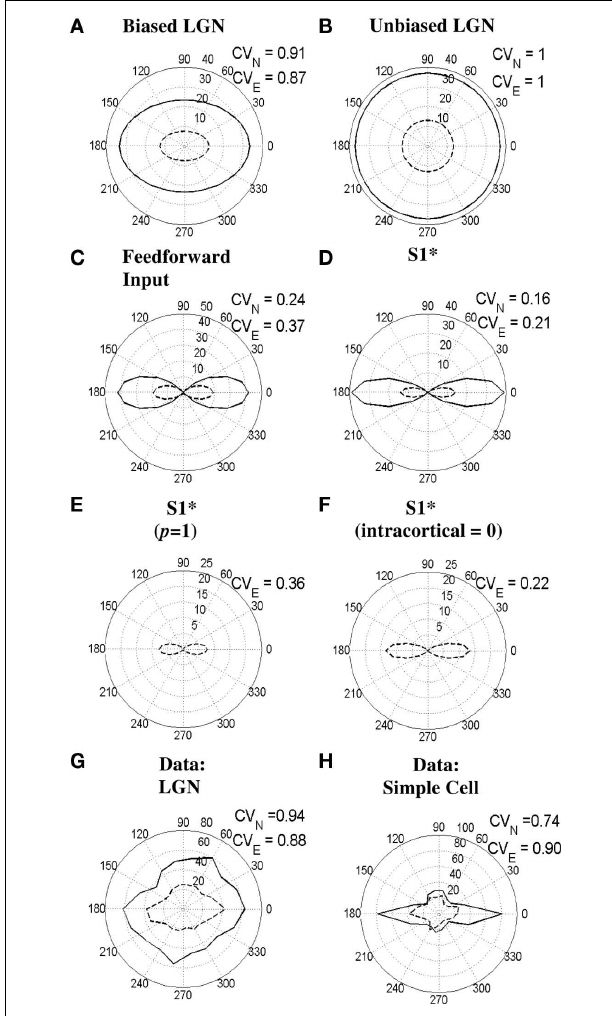
FIGURE 11 | Effects of electrical stimulation in the LGN on orientation selectivity of LGN and simple cells. (A–F) show simulations for the simple cell S1 ∗ (see text) in response to bars of length 4.17˚ either without or during electrical stimulation of the LGN. (A,B) show the responses of the orientation-biased and unoriented LGN cells that provide the feed-forward input to the simple cell, respectively. (C,D) show the responses of the combined feed-forward input to, and the output of, the S1 ∗ simple cell, respectively. (E,F) illustrate the output of the S1 ∗ simple cell when either the power-law exponent is reduced to p = 1 (from 1.85) or the intra-cortical input is set to zero (i.e., W ce = W ci = W se = W si = 0), respectively. (G,H) demonstrate the responses of a real LGN cell and a real simple cell to bars, respectively, both with or without electrical stimulation in the LGN (adapted fromViswanathan et al., 2011). In all subfigures, responses to visual stimulation alone are indicated by the solid lines, whereas responses to visual stimulation during electrical stimulation are indicated by the dashed lines. Moreover, the CV N and CV E values next to each subfigure indicate the circular variance values calculated from the responses to normal visual stimulation alone or visual stimulation during electrical stimulation,